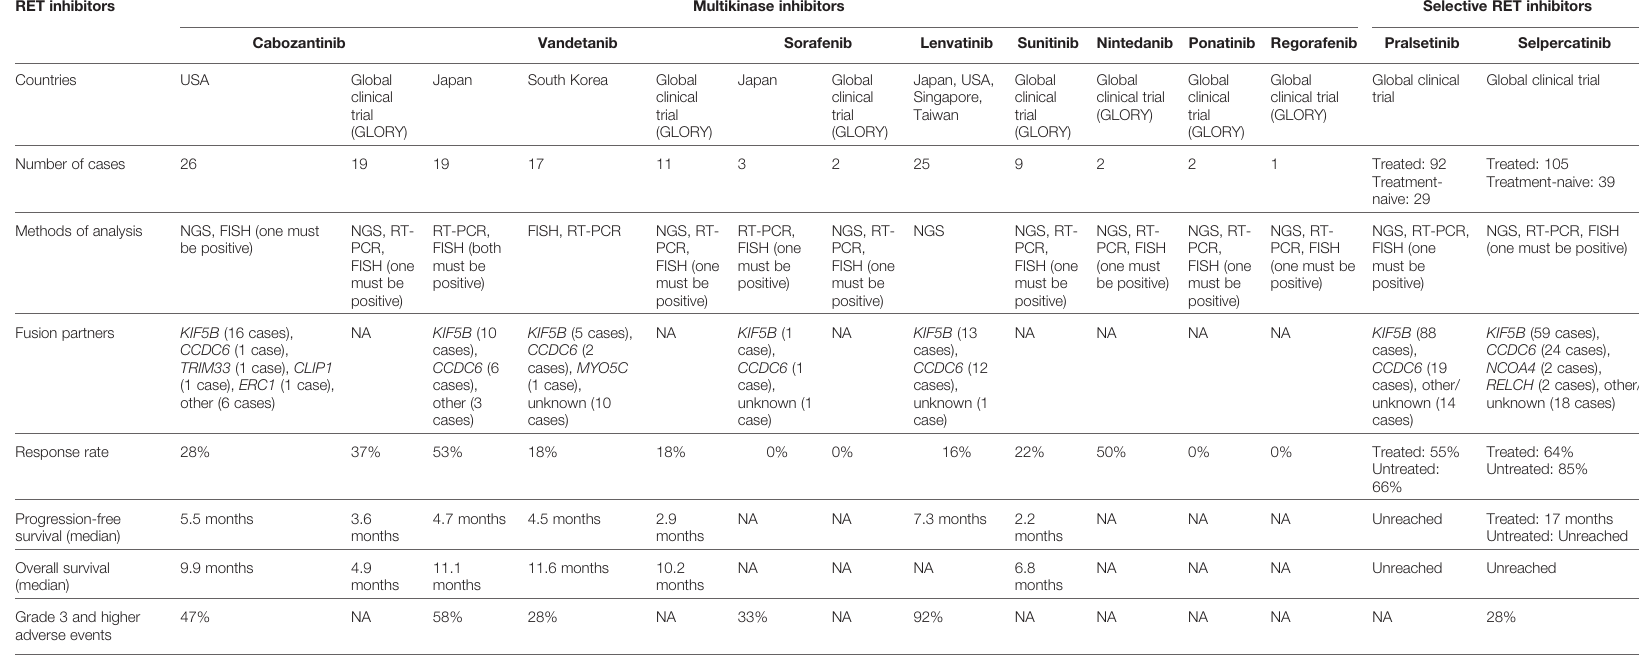
TABLE 1 | Summary of clinical data of RET inhibitors for RET fusion-positive lung